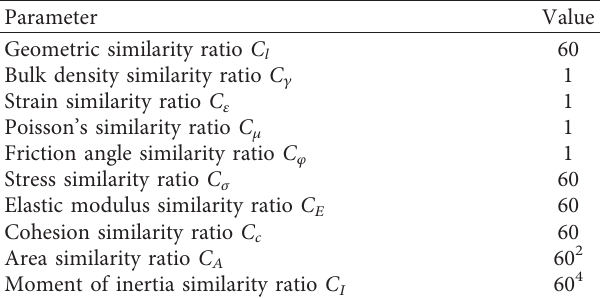
Table 1: Similarity parameters of the tunnel model test.